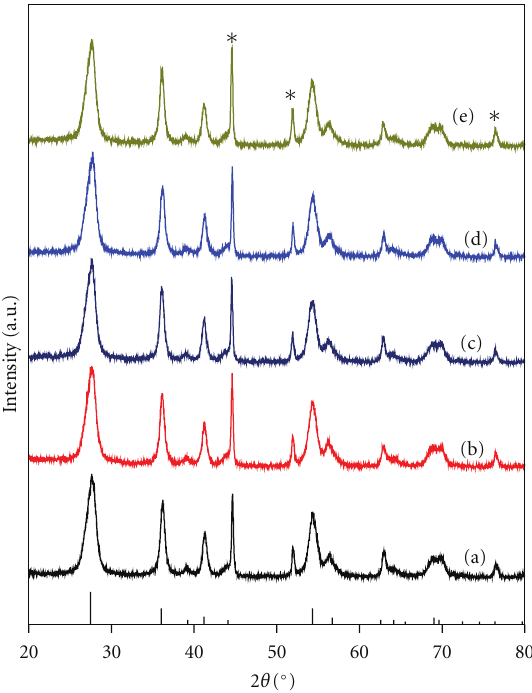
Figure 2: XRD patterns of the samples: (a) PureTiO 2 , (b) 0.1-Pt- TiO 2 , (c) 0.5-Pt-TiO 2 , (d) 1.0-Pt-TiO 2 , and (e) 3.0-Pt-TiO 2 . Vertical bars represent the standard di ff raction data for bulk rutile TiO 2 . ∗ represents the di ff raction lines of internal standard